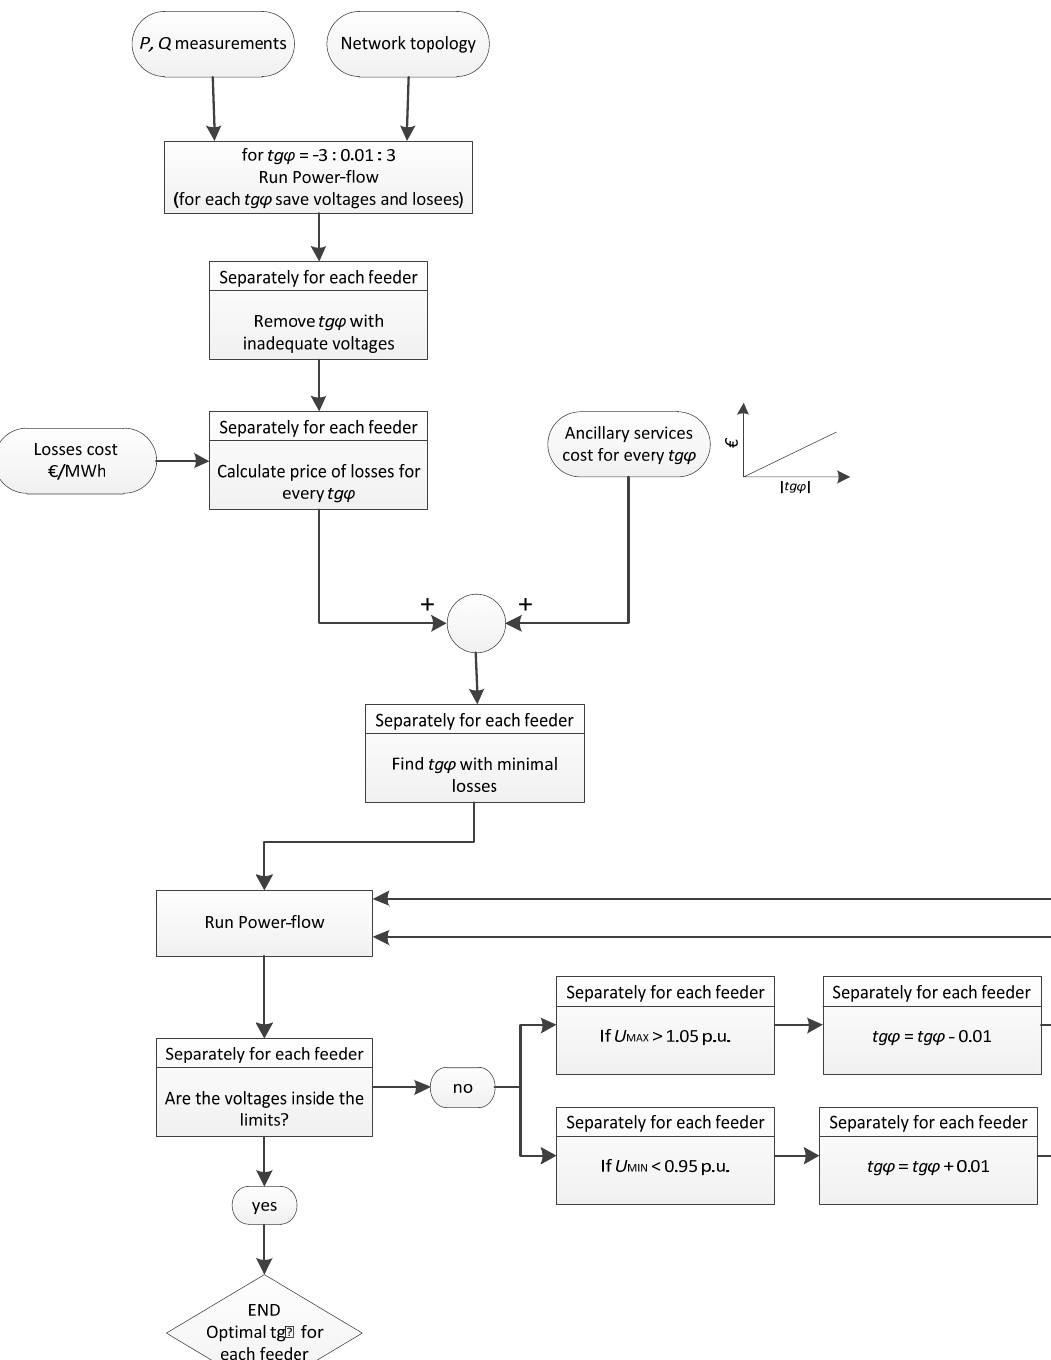
Figure 6. Algorithm